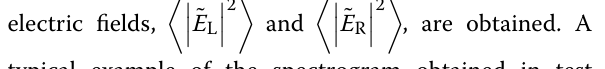
the radio and plasma waves are indicated in Fig. 6a, b, respectively. Since the polarization in the HFA observa- tion is defined with respect to the anti-sunward direc- tion, and the magnetic field is in the sunward direction in the northern hemisphere on the night side, the posi- tive axial ratio (red) indicates left-hand polarization